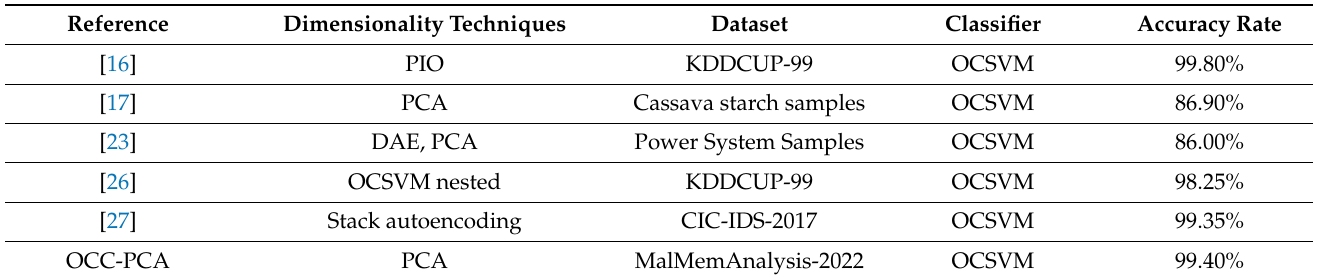
Table 6. Comparison Between the OCC-PCA Model and Literature